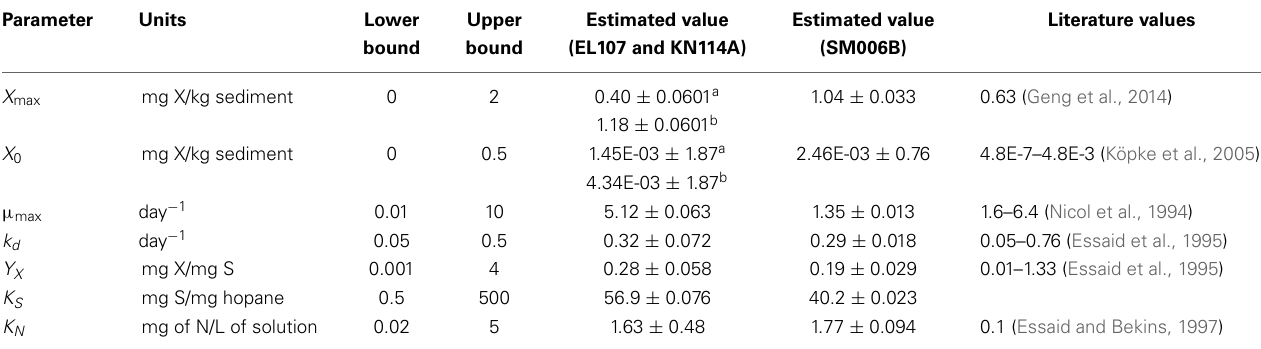
Table 2 | Parameters estimated in the model and their best-fit value.